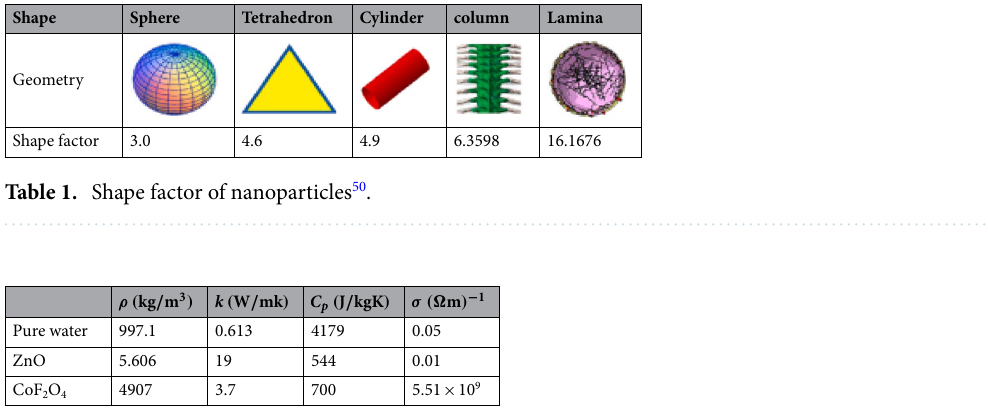
Table 2. The nanoparticles ZnO , CoF 2 O 4 and water thermo-physical features 51,52 .